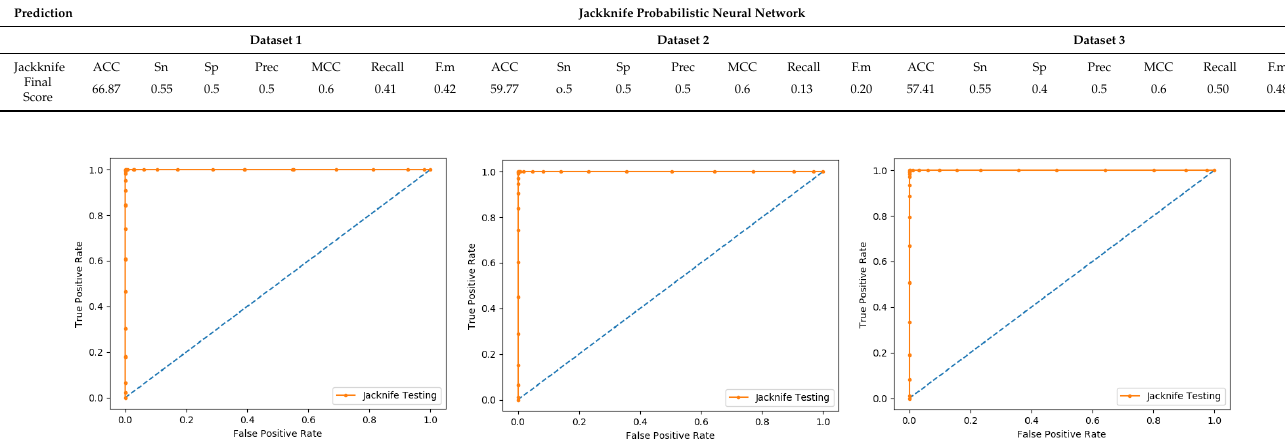
Figure 9. Jackknife PNN ROC curve. 6.5. Self-Consistency Test Self-consistency test is a technique referred to as the ultimate test for the validation of efficiency and efficacy of the prediction model, this method uses the same data for both training and testing A representation of these proposed parameters, by conducting the self-consistency testing, the results for the acetylation protein prediction based on the Ran- dom Forest classifier as presented in the Table 6 and by the ROC curve is shown in the Figure 10. Table 6. Results of self-consistency based on Random Forest. Self-Consistency Random Forest Dataset 1